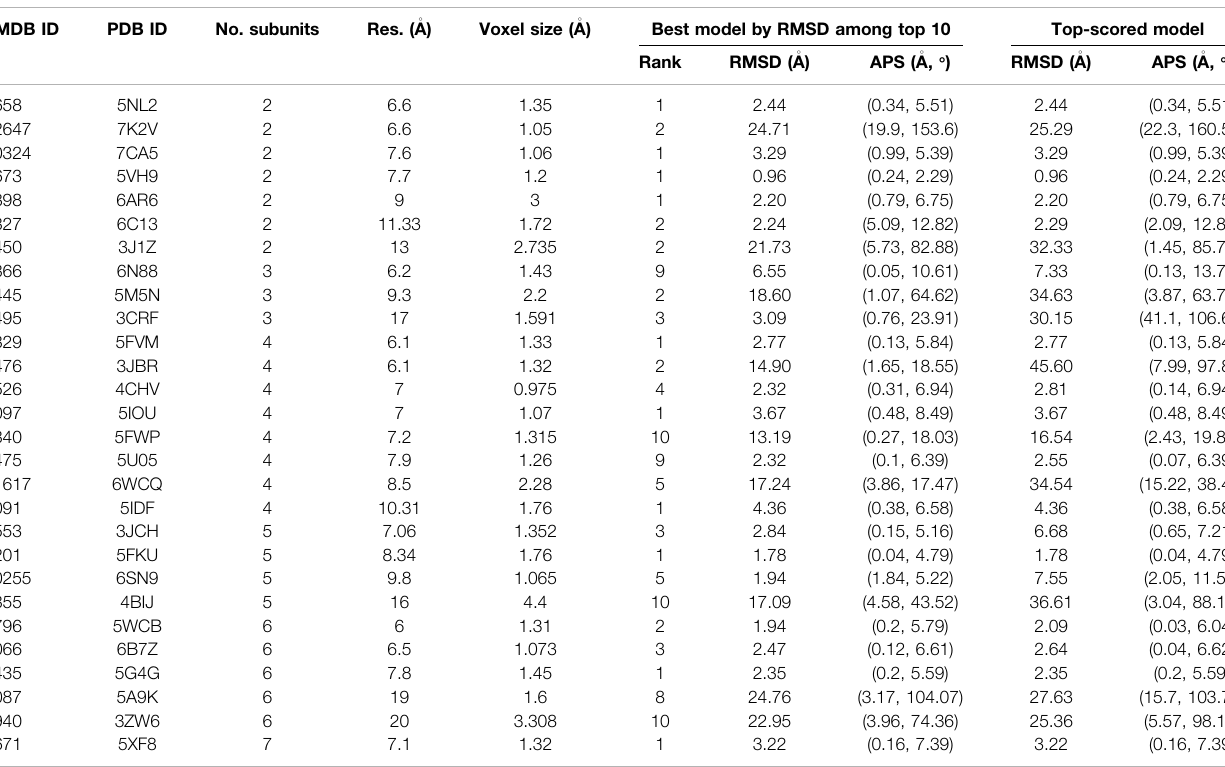
TABLE 3 | Modeling accuracy in the medium resolution experimental map dataset. EMDB ID PDB